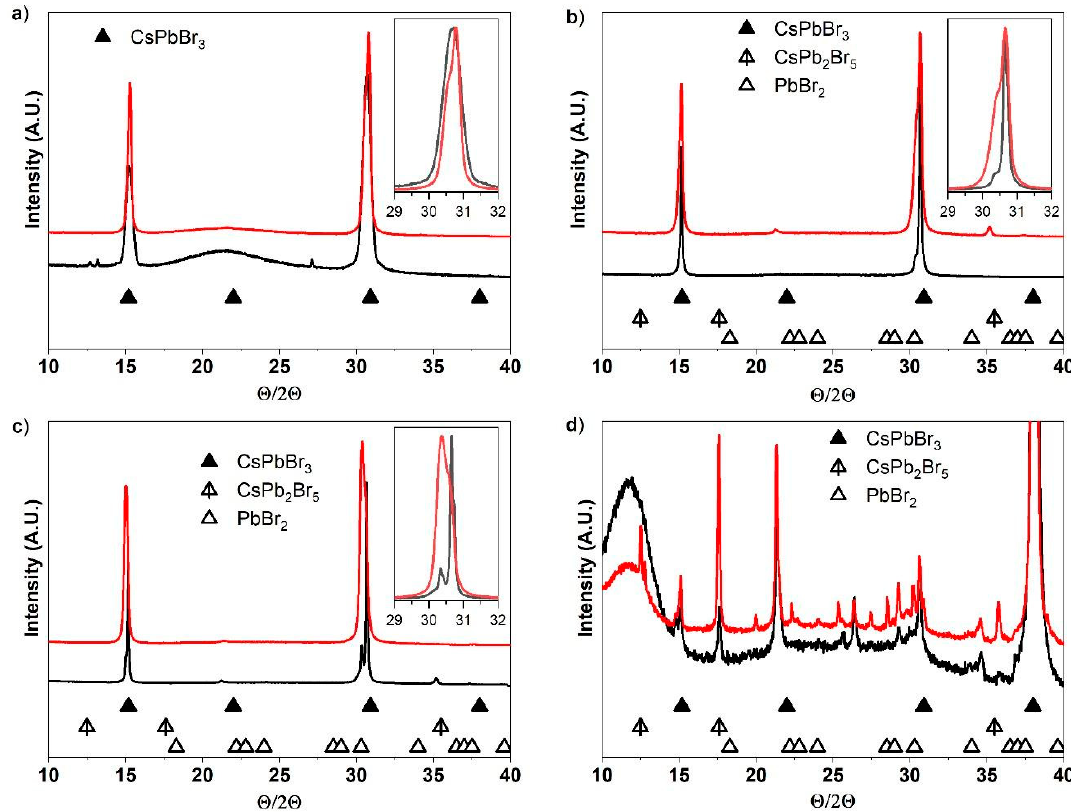
Figure 2. XRD patterns of the “as-prepared” (black lines) and aged (6 days, red lines) samples. As described in the legend, scatter symbols indicate the diffraction peaks for the most common byproduct phases: ( a ) quartz glass; ( b ) ITO; ( c ) soda-lime glass; ( d ) gold. Inset: zoom view of the region of the higher